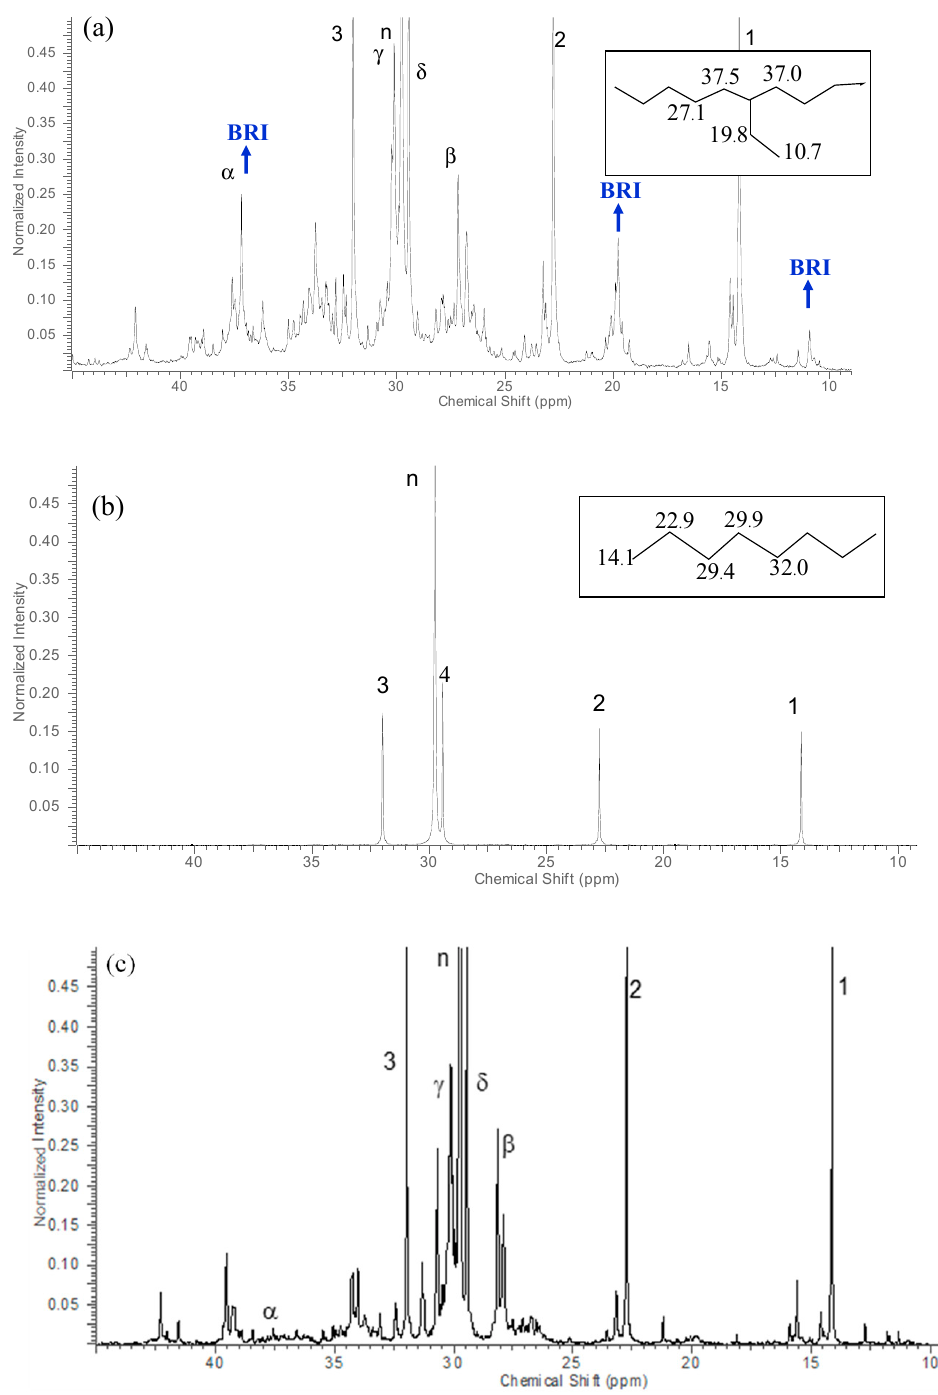
Figure 3. The C 13 -NMR spectrum of ( a ) the oligomer product obtained from the oligomerization experiment operated at a reaction temperature of 483 K and a reaction time of 180 min, ( b ) standard linear hydrocarbons in the range of C 12 to C 18 and ( c ) a conventional poly-alpha-olefin lubricant oil (PAO) where BRI is a branch hydrocarbon at any carbon location.